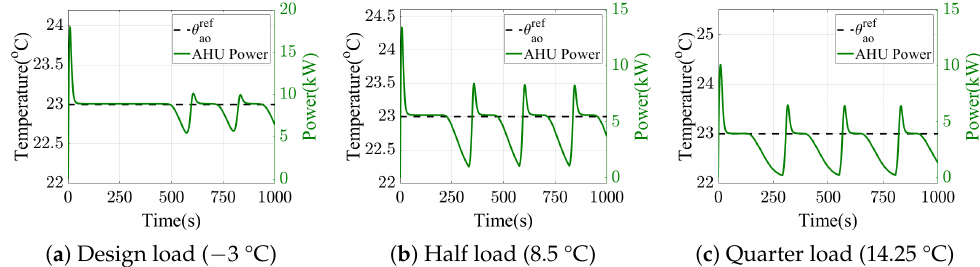
Figure 8. AHU system power consumption with H ∞ controller at three different thermal load conditions (step